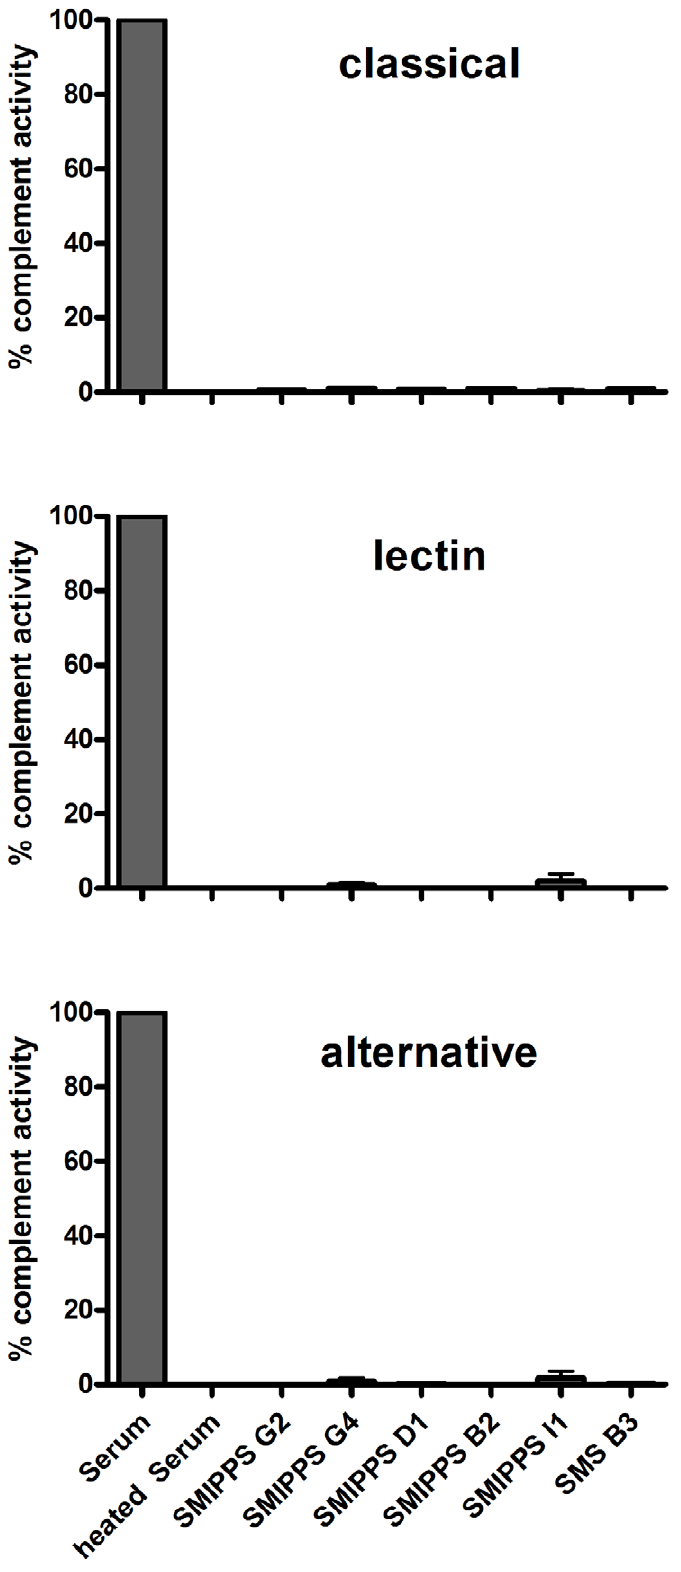
Figure 1. Inhibition of human complement by excretory mite proteins. Shown are the effects of five recombinant, purified SMIPP-Ss (I1, D1, B2, G2, G4) and one SMS (B3) on the Classical (CP), Lectin (LP) and Alternative (AP) pathways of the human complement system. In ELISA-based complement activation assays 50 m g/ml of each recombinant protein showed strong complement inhibition. Data presented were obtained in triplicates and is representative for three to five independent experiments for each mite protein. Shown is the percentage of complement activity as the mean 6 SD.